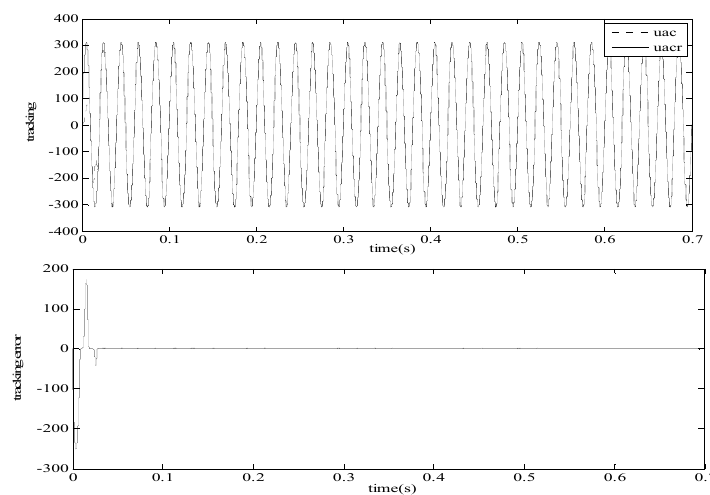
Figure 11. Performance of the DC-AC inverter with the AFSMC scheme.